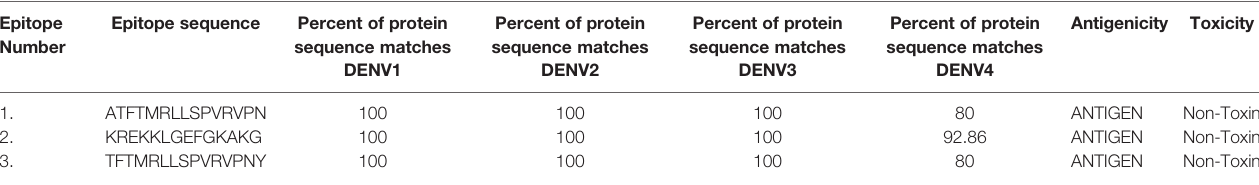
TABLE 1 | Selected epitope peptide conservancy